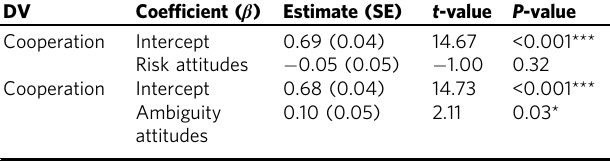
Where risk and ambiguity attitude are indexed by subject ( i ). Ambiguity attitudes were inverted to align on the same scale as risk attitudes, and risk and ambiguity attitudes were standardized before being entered into the regression. Cooperation is the proportion of cooperative choices taken in the fi rst three trials of the PD where there was not an opportunity to sample * p <0.05; *** p